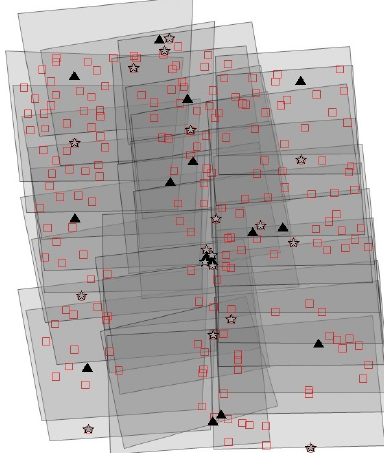
Figure 9. Triangulated RGB block, with GCPs (triangles), CPs (stars) and the 181 manual TPs (squares)